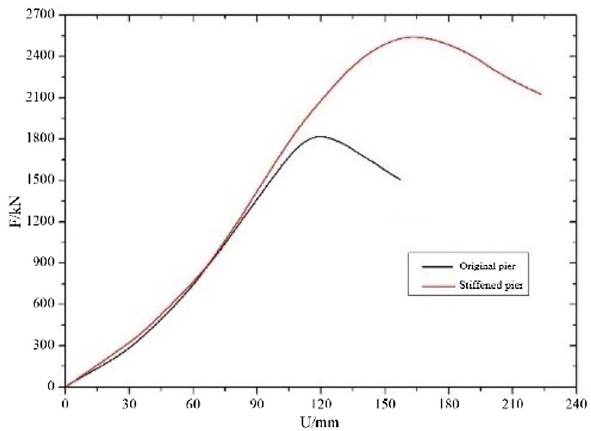
Fig. 21 Comparison of FE